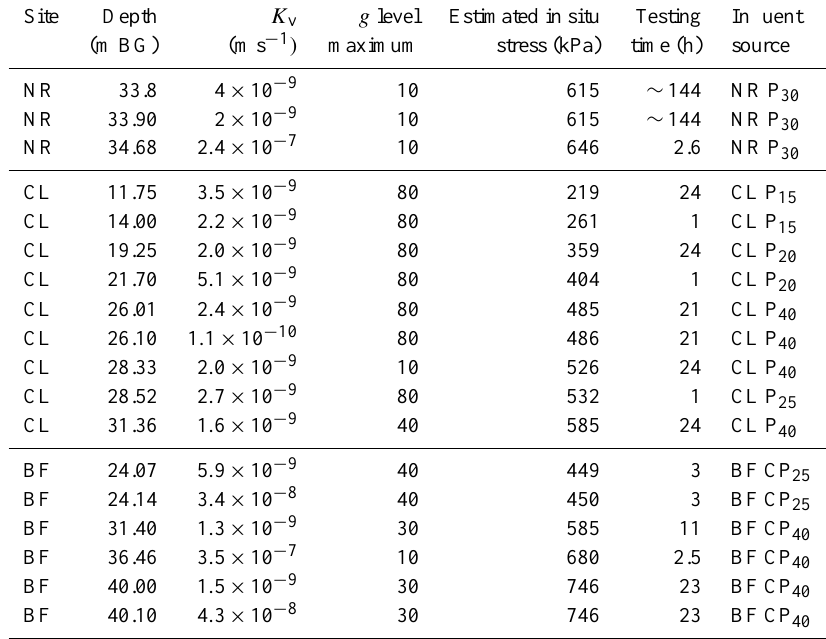
Table 3. K v results from CP tests indicating g level maximum and testing time. The influent source column identifies the site (NR, CL, BF) and depth (P 20 is piezometer screen at 20m depth) of groundwater sampling. Calculations were based on Eq. (3) for in situ